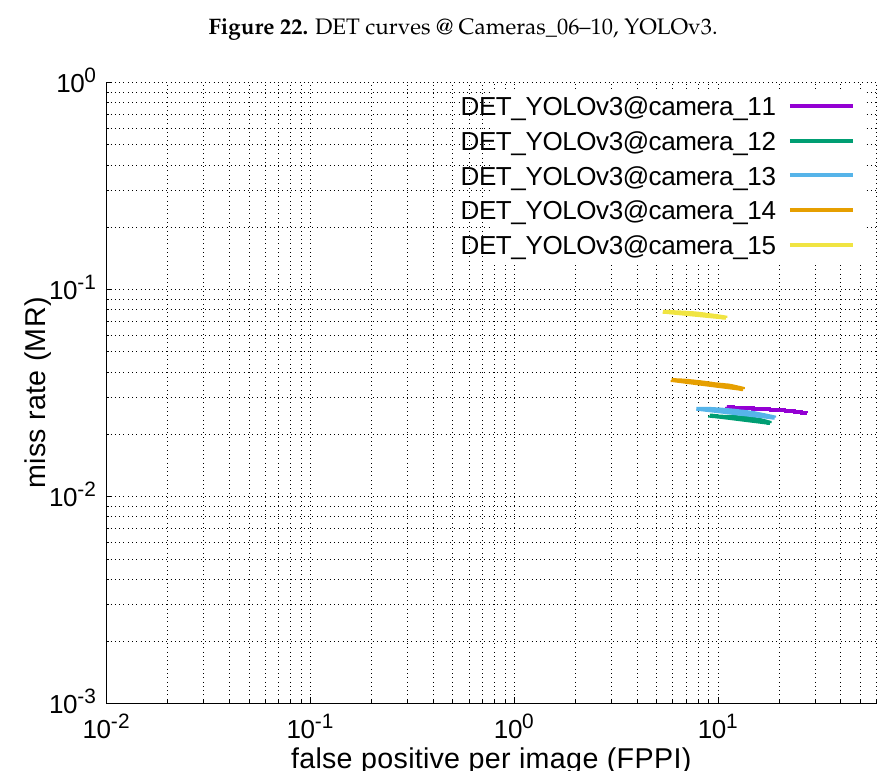
Figure 23. DET curves @ Cameras_11–15,